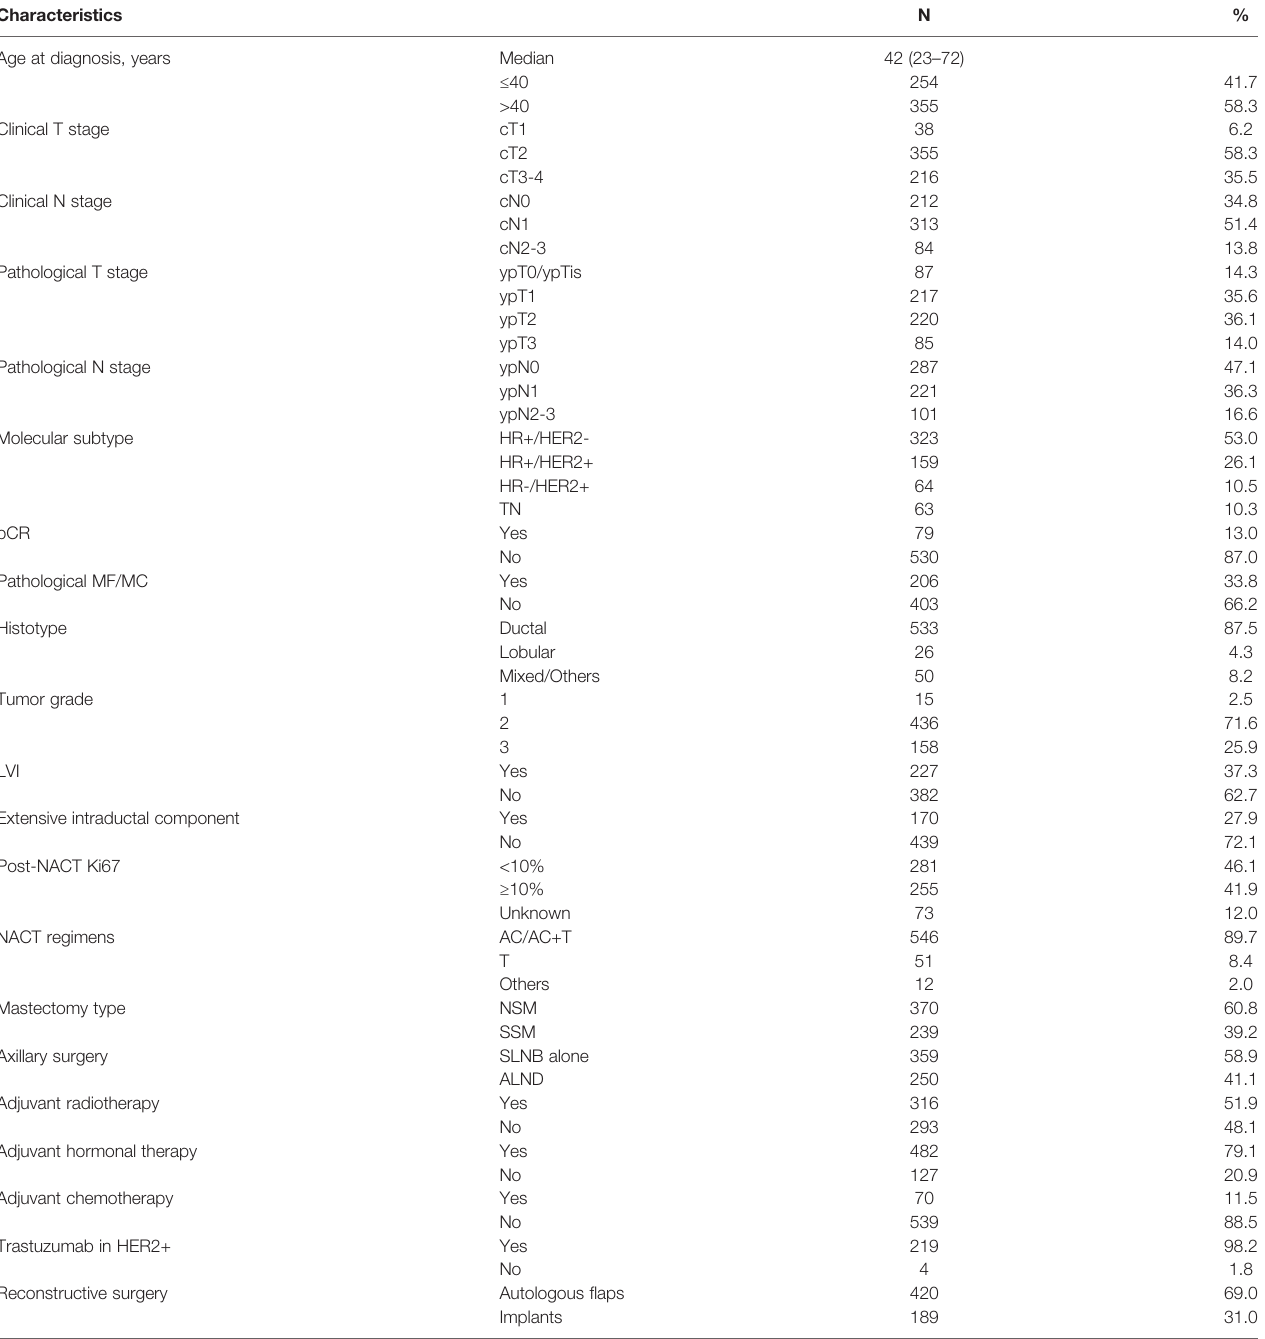
TABLE 1 | Patient, tumor, and treatment characteristics (N=609).